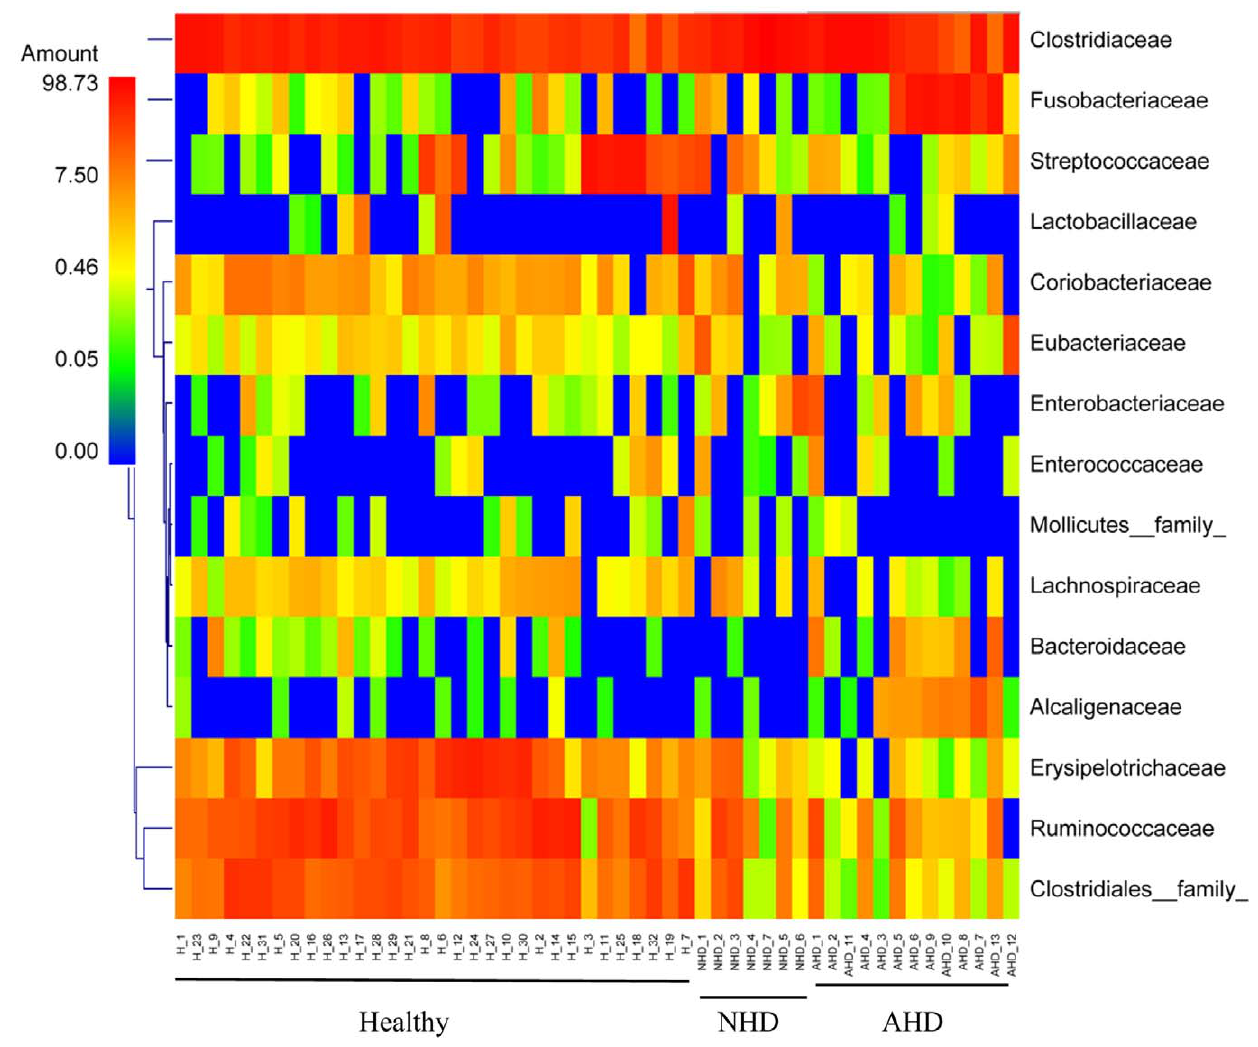
Figure 6. Heatmap illustrating the relative abundance of predominant bacterial families in fecal samples of healthy dogs and dogs with acute diarrhea based on 454-pyrosequencing. Samples from healthy dogs (H), dogs with acute non-hemorrhagic diarrhea (NHD), and dogs with acute hemorrhagic diarrhea (AHD) are shown. The heatmap represents the relative percentage of each family within each sample.